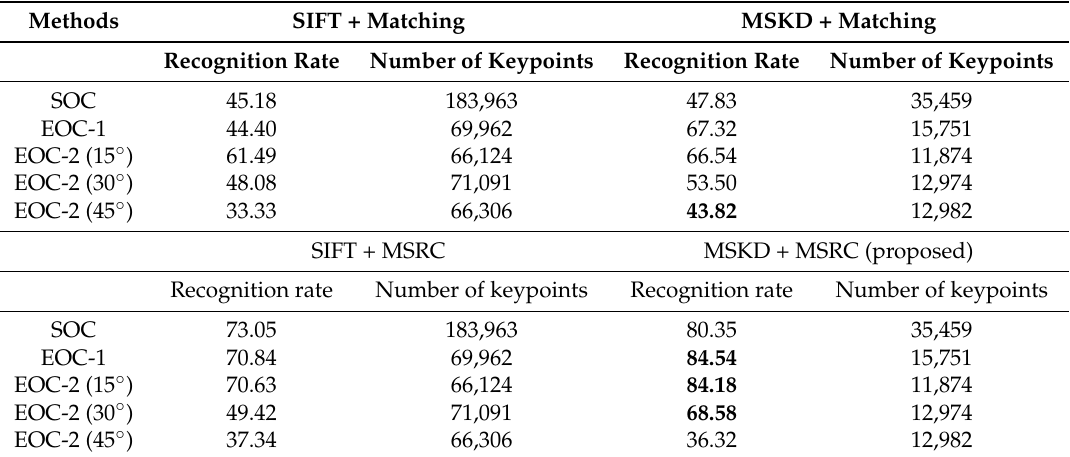
Table 6. Comparison between the recognition rate (%) of different methods on MSTAR dataset.